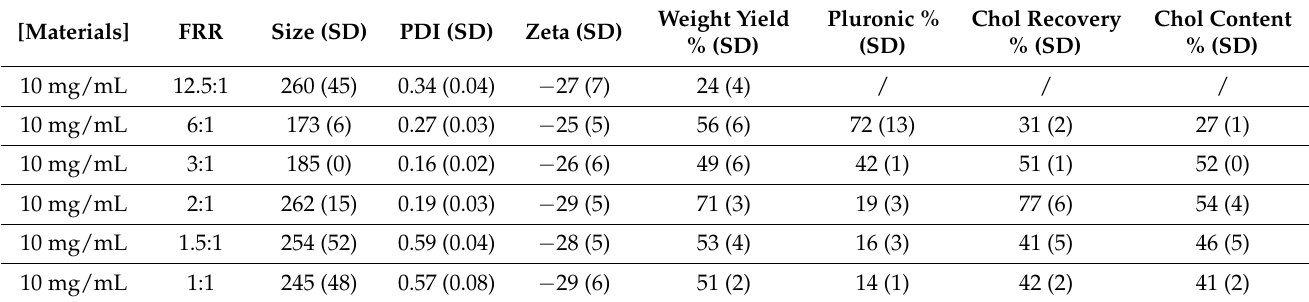
Table 2. Physico-chemical characterization of H-NMeds obtained with the microfluidic device varying the Flow Rate Ratio (FRR). Standard Deviation (SD) is reported in